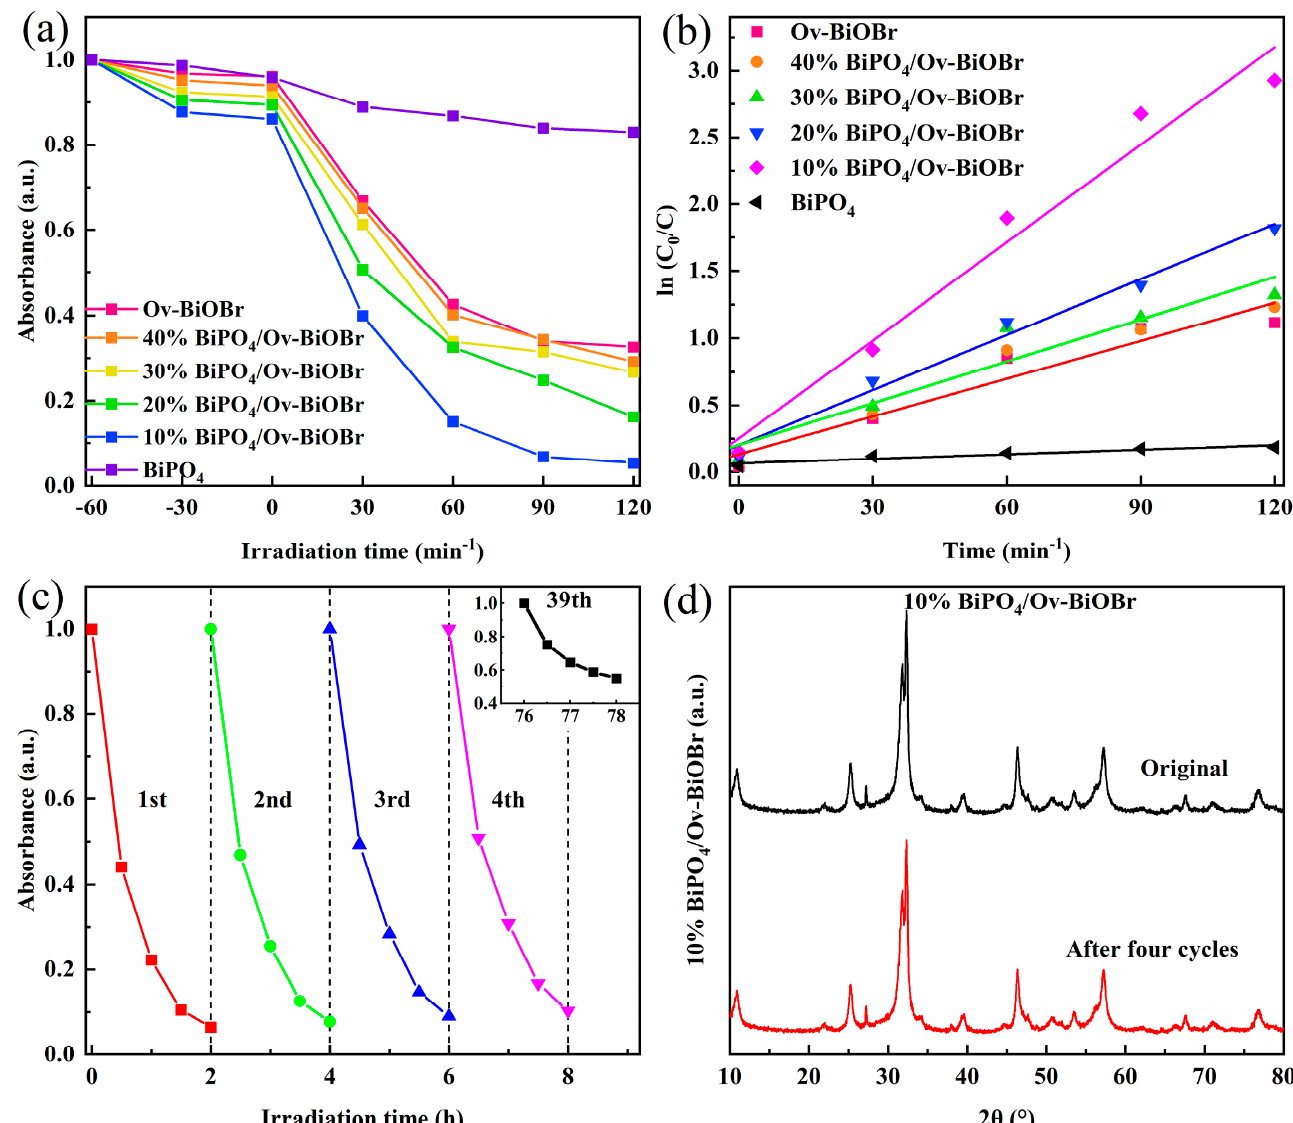
Figure 8. Photodegradation curve ( a ) and photodegradation kinetic curve ( b ) of TC; photodegradation cycle test curve ( c ) and XRD detection before and after illumination of BiPO 4 /Ov-BiOBr ( d ). Table 1. Recent work of BiOBr-based heterojunctions in degradation of TC.